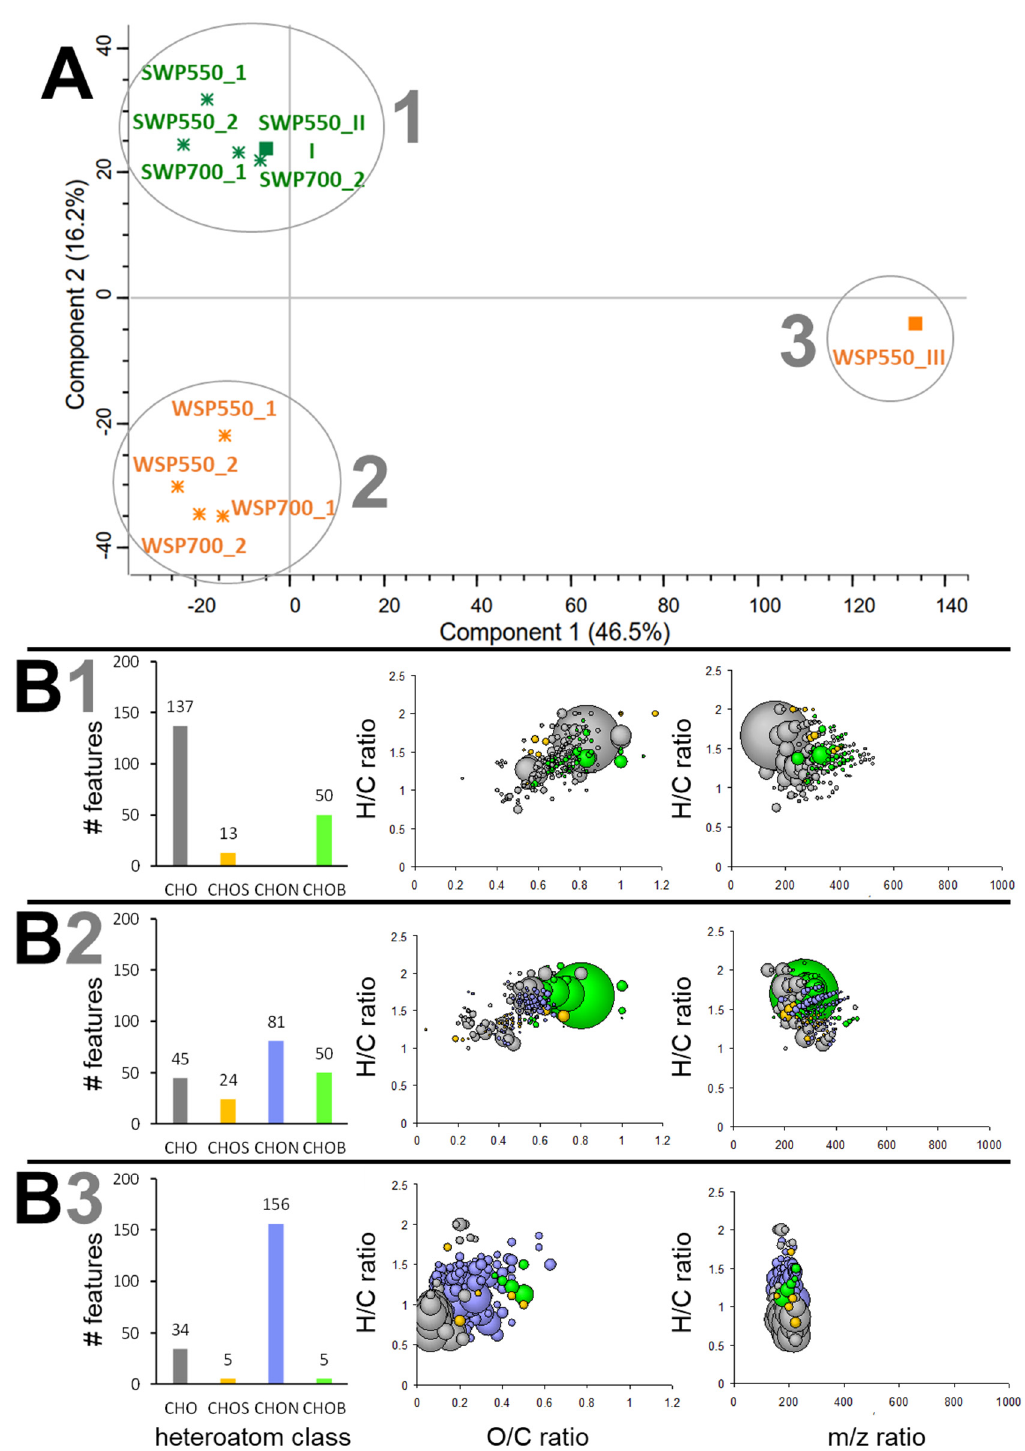
Figure 2. ( A ) Principal component analysis (PCA) score plot of all m/z features from bio-oils measured by ESI ( − ) FTICR MS. Wheat straw pellets-derived bio-oils in orange, softwood pellets bio-oils in green, small-scale unit bio-oils highlighted by a star and pilot-scale bio-oils by a full square. ( B ) Two hundred features specific to group 1, 2 and 3 observed in panel ( A ) were extracted and represented as (from left to right) bar chart according to their heteroatom classes, van Krevelen diagram (O/C vs. H/C) and m / z vs. H/C-ratios. The bubble size is relative to peak intensity.